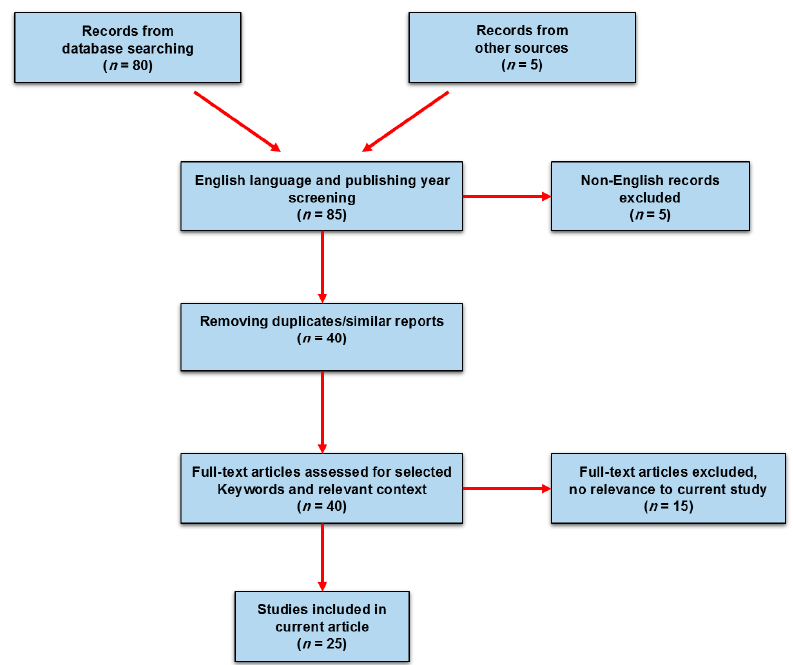
Figure 1. Literature search and inclusion/exclusion criteria for systematic reporting of pharmacogenetics and genomics (PGx) studies in follicle-stimulating hormone receptor (FSHR) malfunction in females with poor ovarian response.